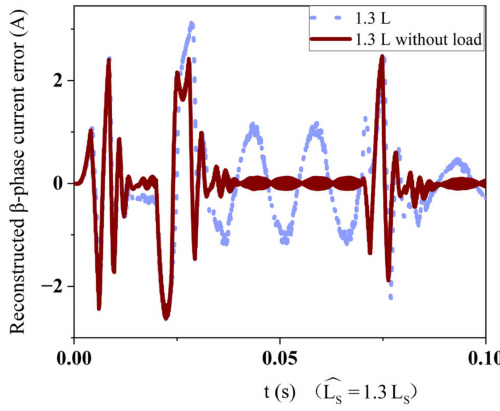
Figure 13. Mismatched β -axis current error.